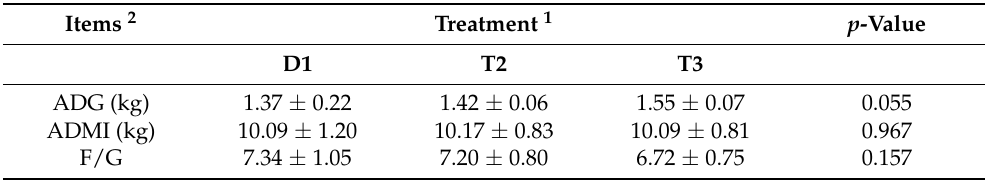
Table 3. Effects of low-protein dietary inclusion of RPLys and RPMet on average daily gain, average daily feed intake, and feed/gain ratio of Holstein bulls.